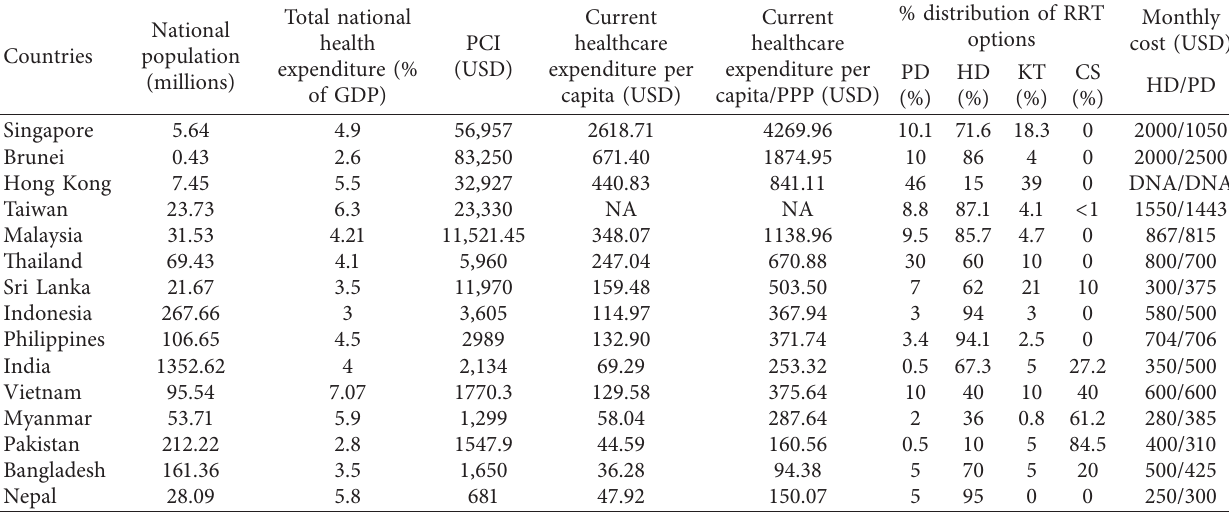
Table 3: Country-wise RRT cost and healthcare expenditure per capita in SA and